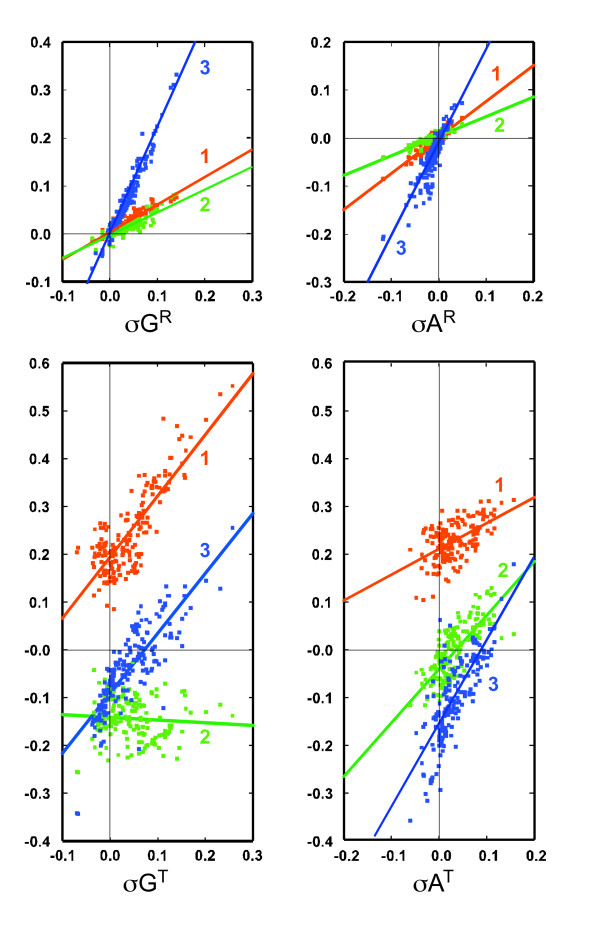
RAP and TAP at the three positions of codons. σGR, σAR, σGT, and σAT at three positions of codons (y-axis) are plotted against the overall σGR, σAR, σGT, and σAT, respectively (x-axis). Red, position 1; green, position 2; blue, position 3. The linear regression trend lines for each position are depicted.